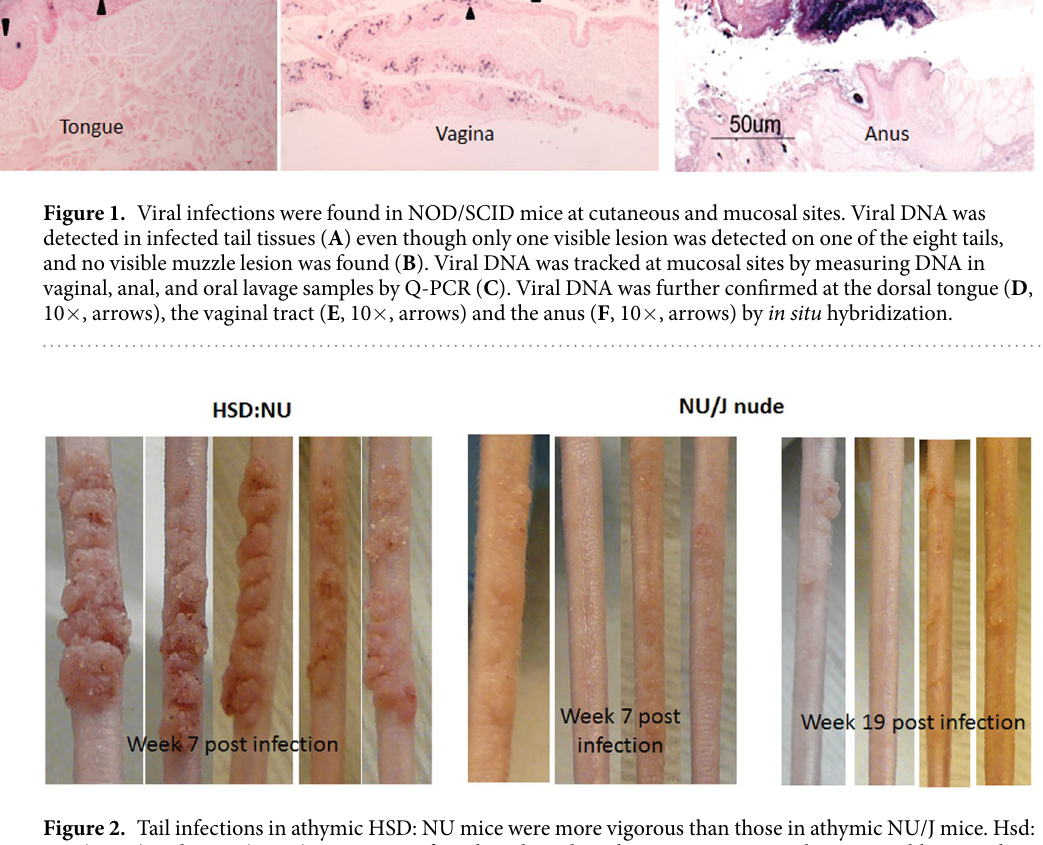
MmuPV1 disease persisted in mucosal tissues in homozygous NU/J mice. One of the four infected homozygous NU/J mice died before the termination of the experiment. The remaining three animals (Ho#1-#3) were positive for viral capsid protein by immunohistochemistry of the lower genital tract (Fig. 6A–C, 10 × , and arrows). There were scattered foci of ambiguous microinvasion in these infected tissues (Fig. 6D–F, 20 × , and arrows). The stratified squamous cornifying epithelium of the anal canal displayed diffuse mild hyperplasia and hyperkeratosis (Fig. 6G, 10 × , and arrows). There was minimal atypia or obvious viral cytopathic effect (CPE) in